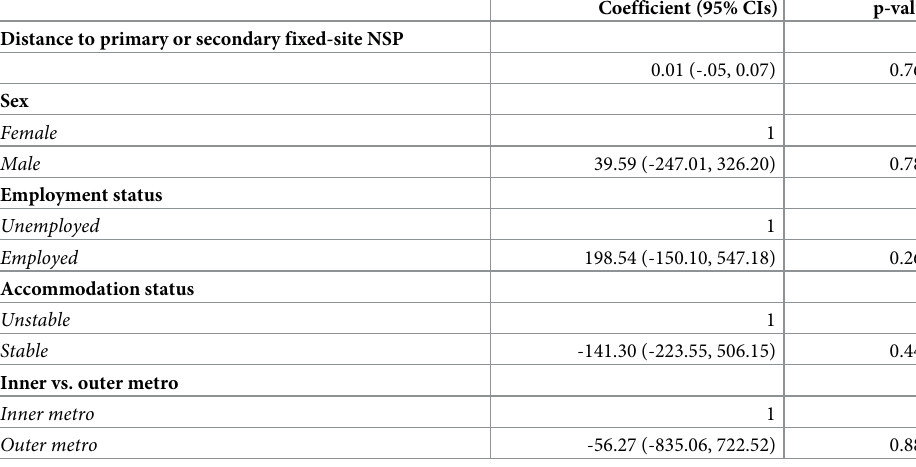
Table 3. Linear regression testing association between distance to nearest NSP service and continuous coverage amongst PWID in Melbourne, Australia (2015–2016).